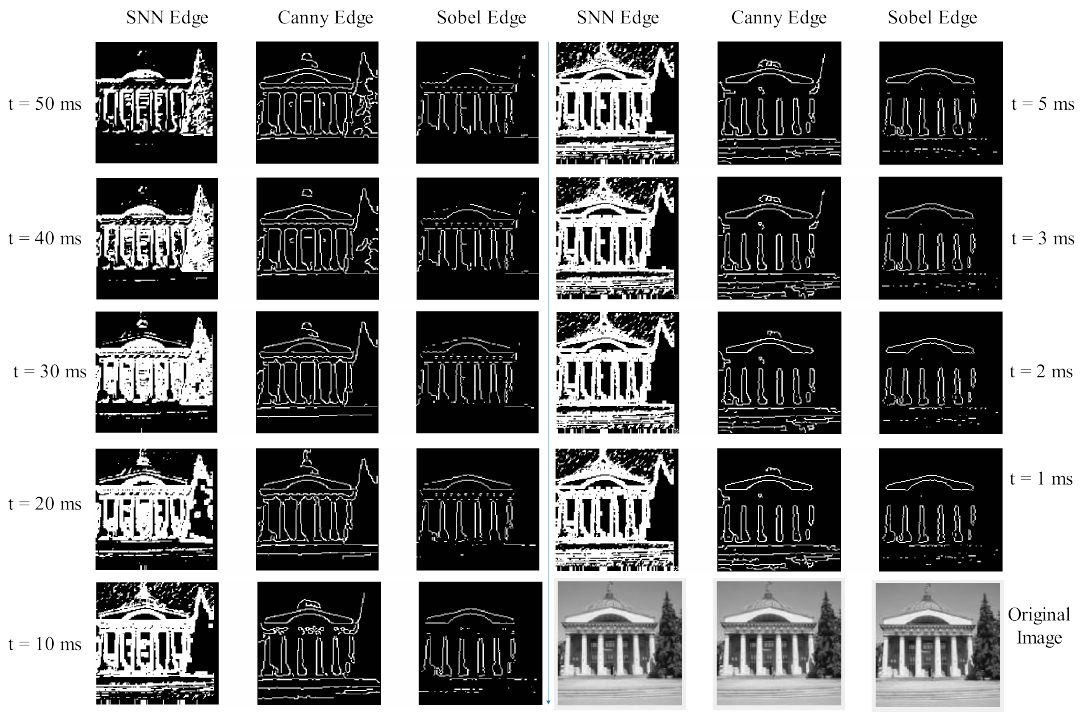
Figure 5. Comparison of edge detection methods for low exposure frames, t = 1 − 50 ms with an example image from MIT Sun